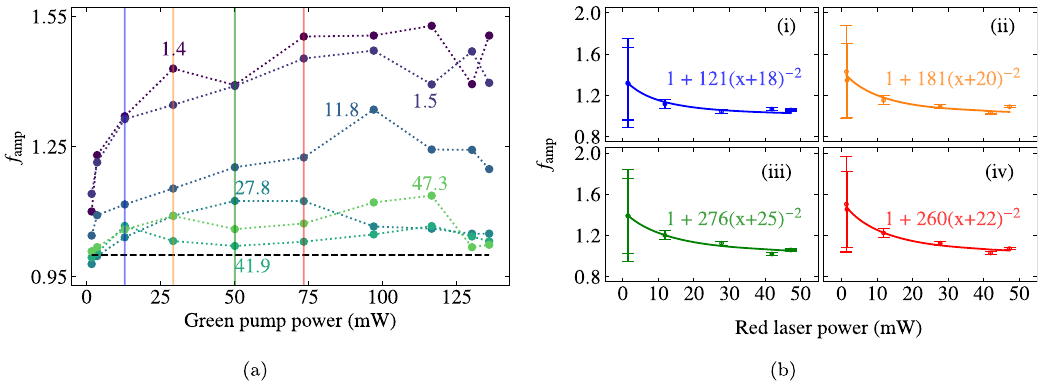
Figure 4: Dependence of f amp on red power. (a) f amp as a function of green pump power for different red powers. Red laser power in mW, corresponding to each curve, is annotated in respective colours. (b) Line cuts through (a) give f amp as a function of red laser power for fi xed greenpumppower.Theblue,orange,green,andredcoloursin(i),(ii),(iii),and(iv)correspondtogreenpumppowersof ∼ 12.9mW, ∼ 29.2mW, ∼ 50.1mW,and ∼ 73.4mW,respectively.Thesolidcurveswithrespectivecoloursarefromthe fi tfunctionsannotatedineach fi gures.Forclarity, error bars, which are obtained in the same manner as Figure 3, are shown only in